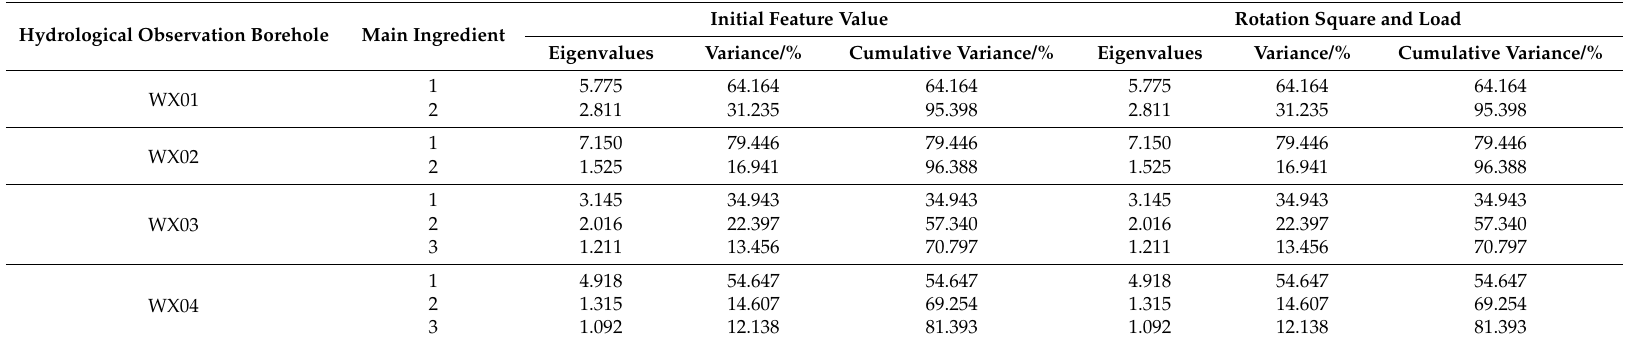
Table 4. Eigenvalues and cumulative contributions for the factor analysis.